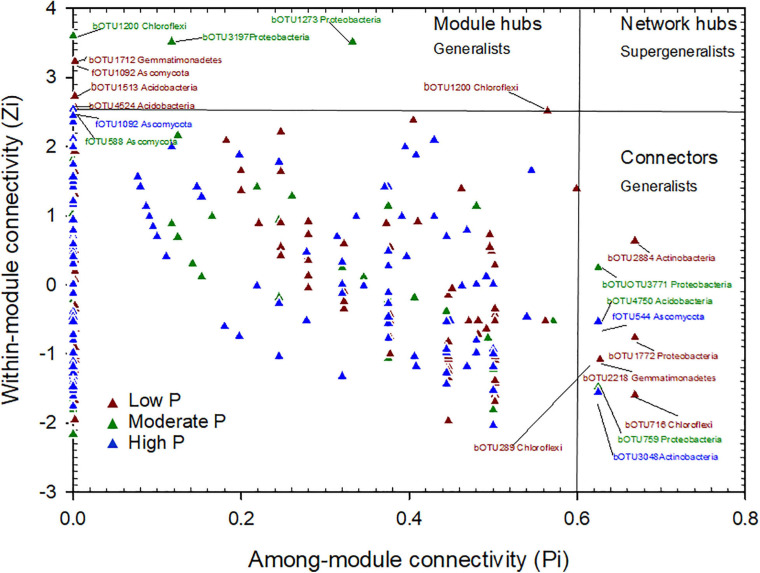
Zi-Pi plot showing the distribution of OTUs based on their topological roles. Each symbol represents an OTU in the low P (red triangle), moderate P (green triangle) and high P (blue triangle) network of maize field. The threshold values of Zi and Pi for categorizing OTUs were 2.5 and 0.62, respectively.